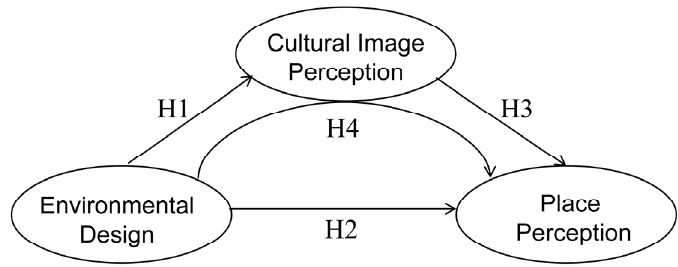
Figure 3. Hypothesis model of the three